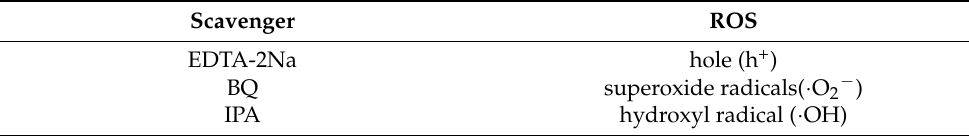
Table 2. Reactive oxygen species and h+ can be trapped by various